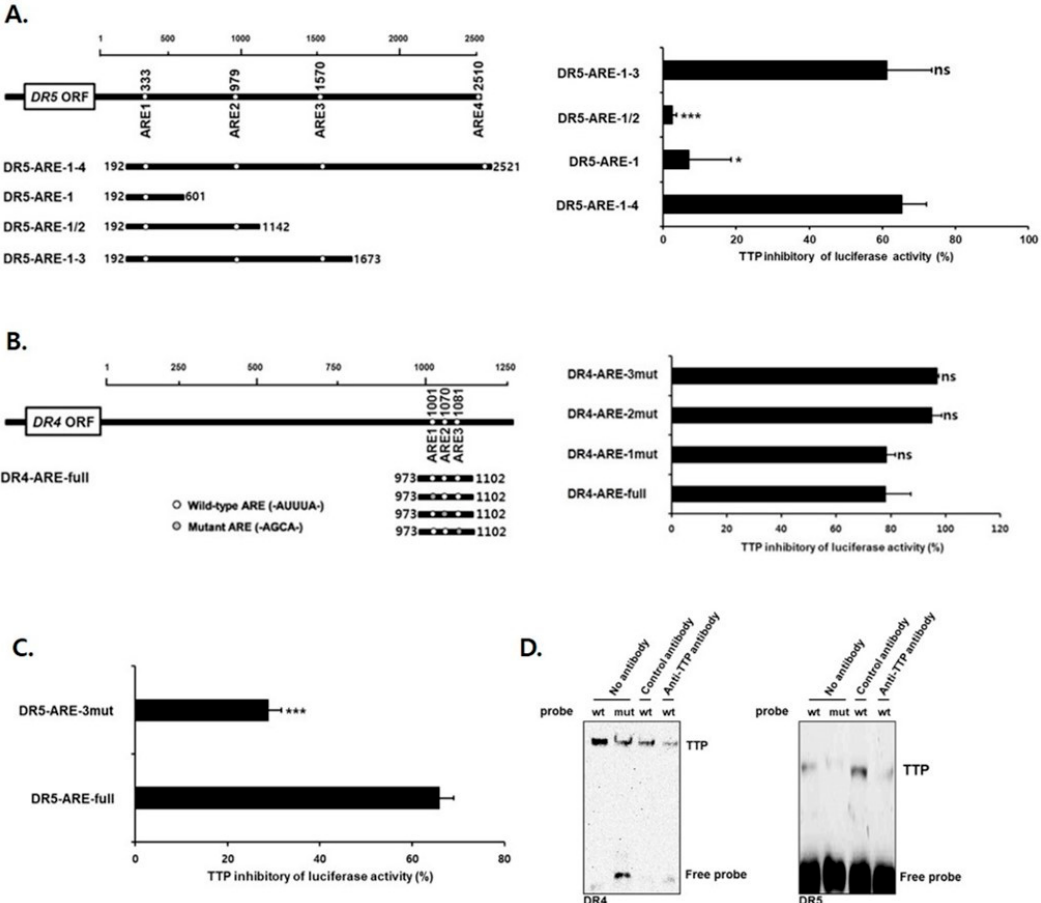
Figure 4. ARE3 within DR5 and all three AREs in DR4 mRNA 3 ′ -UTR are essential for the inhibitory effect of TTP. Schematic representation of luciferase reporter constructs with ( A ) 2521-bp DR5 and ( B ) 1250-bp DR4 mRNA 3 ′ -UTR used in this study. White circles represent wild-type pentameric motif AUUUA, and gray circles represent mutated (mut) motif AGCA. ( A ) Only fragments with 3rd ARE within the DR5 3 ′ -UTR show TTP-mediated inhibition of DR5. ( B ) Each single mutant of DR4-ARE showed a similar TTP inhibitory effect. ( C ) A single mutant of 3rd ARE of DR5 was confirmed to prevent the TTP inhibitory effect. Fragments derived from 2521-bp DR5 and 1250-bp DR4 mRNA 3 ′ -UTR were cloned downstream of the luciferase reporter gene in psiCHECK luciferase expression vector. Inhibition of luciferase reporter containing DR5 and DR4 3 ′ -UTR by TTP overexpression. Mapping of sequence in DR5 and DR4 mRNA 3 ′ -UTR required for TTP inhibition of luciferase activity. SW480 cells were co-transfected with 500 ng of psiCHECK luciferase reporter construct containing fragmented or full AREs in DR4/5 and pcDNA6/V5-TTP or empty vector pcDNA6/V5. TTP-induced inhibition of luciferase activity observed with each construct was compared to that obtained with empty vector pcDNA6/V5. Cells were harvested, and luciferase activity was normalized to firefly activity. Luciferase values obtained from cells transfected only with luciferase construct full AREs were set to 1. Results represent the mean ± SD of three independent experiments (* p < 0.05; *** p < 0.001). ORF, open reading frame; ns, not significant. ( D ) RNA EMSA; RNA EMSA was performed by mixing cytoplasmic extracts containing 4 μ g of total protein from pcDNA6/V5-TTP-transfected SW480 cells with 20 fmol of biotinylated wild-type (wt) or mutant (mut) probe. Control antibody or anti-TTP was added to reaction mixtures. Binding reactions were then separated by electrophoresis on 5% polyacrylamide gel under nondenaturing conditions. TTP indicate the position of the TTP-containing band.